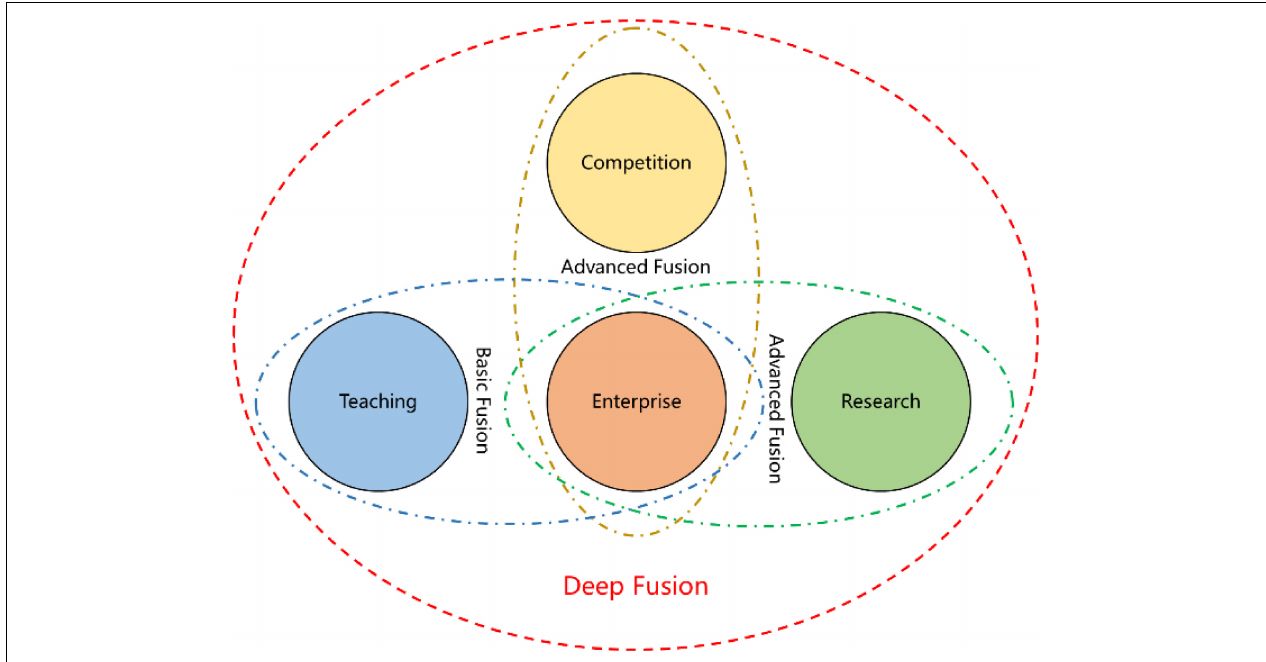
FIGURE 5 | Deep integration of ICRC.